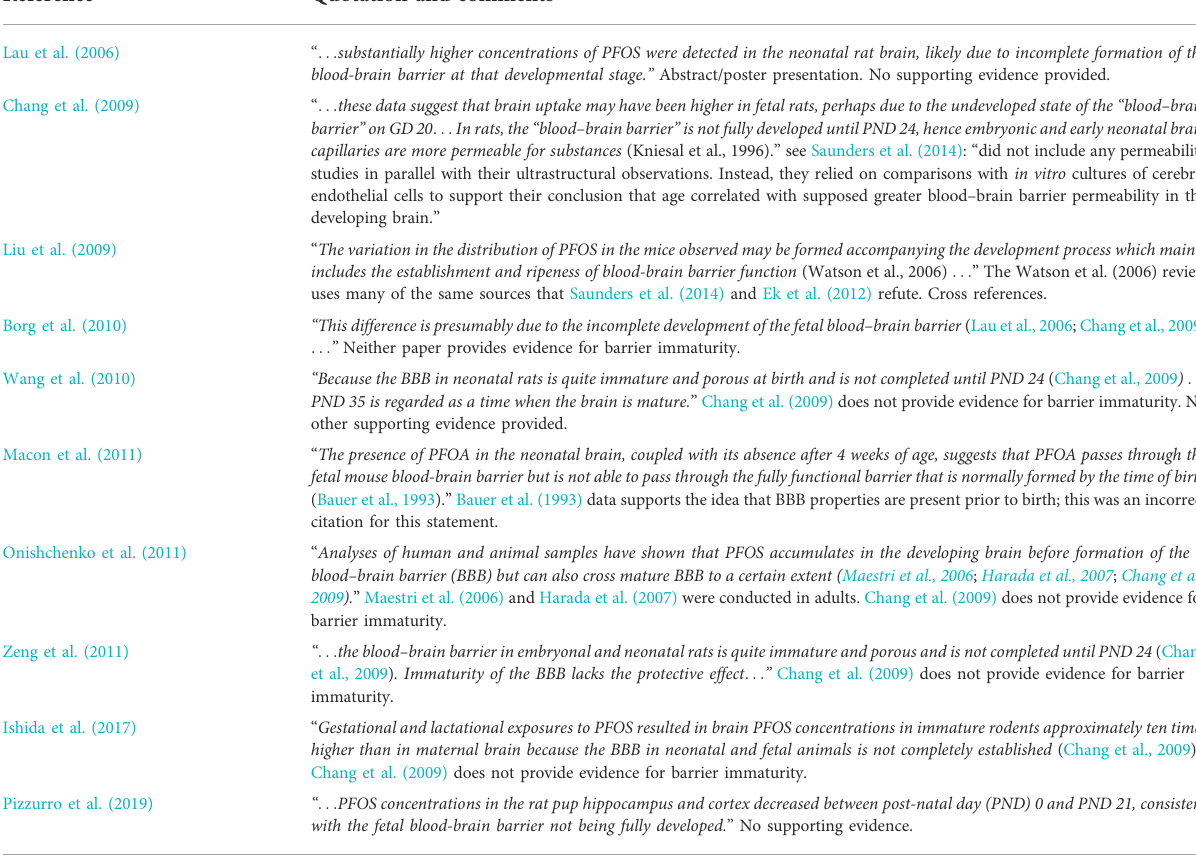
TABLE 4 Statements regarding an immature blood-brain barrier as reasoning for per fl uorooctanoic acid (PFOA) or per fl uorooctanesulfonic acid (PFOS) crossing into the developing brain with comments regarding the unsupported